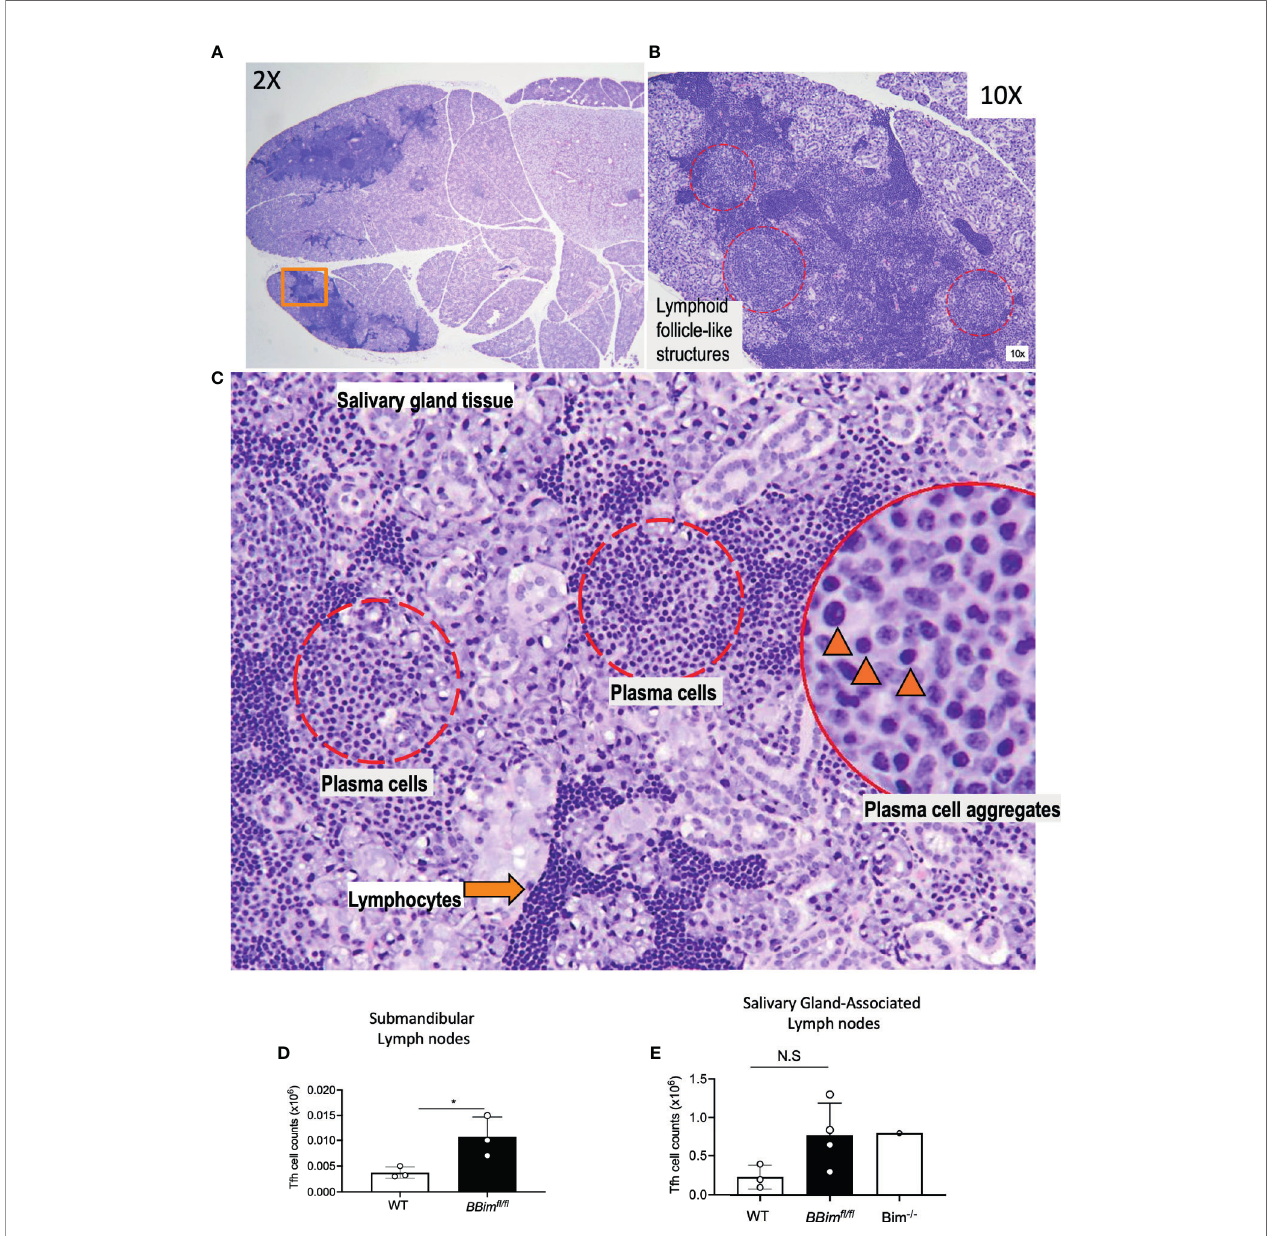
FIGURE 4 | Salivary glands in BBim fl / fl mice display ongoing immune reaction. (A) Salivary gland from an 8.5 month old BBim fl / fl mouse showing aggregates of lymphoid in fi ltrates (H&E, 2x magni fi cation). (B) Region of salivary gland indicated by an orange rectangle in (A) , showing pale areas with of lymphoid follicle-like structures (red dotted circles, 10x). (C) Higher magni fi cation (20x) of one of these areas demonstrates plasma cell aggregates (red dotted circles); plasma cells are identi fi ed by ovoid cells with abundant pale basophilic cytoplasm and eccentric nucleus (inset, black arrowheads, 40x), adjacent to lymphocytic in fi ltrates identi fi ed by smaller cells with scant cytoplasm and prominent dark round nucleus (orange arrow). (D) Numbers of Tfh cells in the submandibular lymph nodes and (E) salivary gland associated lymph nodes. Not signi fi cant (N.S) P > 0.05, *P ≤ 0.05, calculated by Students T-